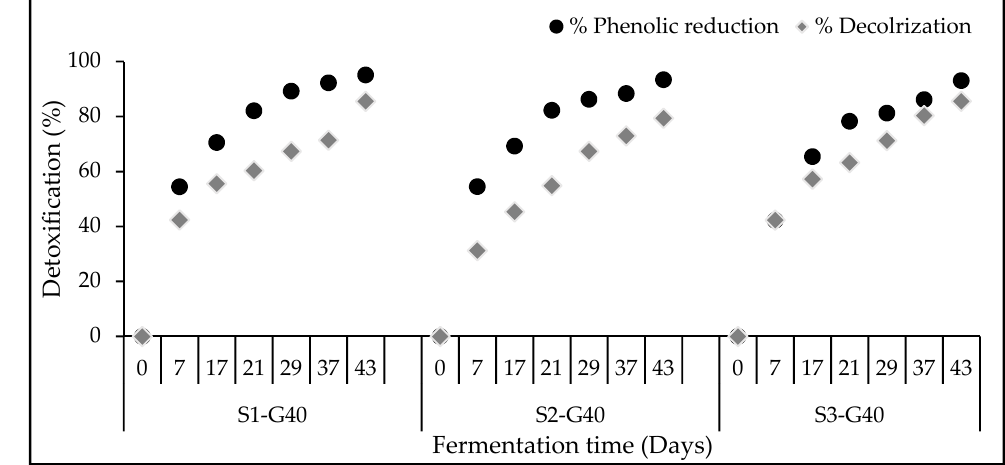
Figure 3. Kinetics of % phenol reduction and % decolorization of the medium during cultivation of P. pulmonarius in liquid cultures with OMWs containing 1, 2 and 3 g/L phenolic compounds and initial concertation glucose ( a ) 40 g/L (S1-G40, S2-G40, S3-G40) and ( b ) 60 g/L (S1-G60, S2-G60, S3- G60, see Table 2). Each point is the mean value of at least three independent measurements, SD < 5%. can produce ligninolytic enzymes that degrade the phenolic compounds. In particular, the ability of detoxification and decolorization of P. citrinopileatus LGAM 28684, in batch cul- tures with a concentration of OMW (25%, v/v ) was studied by Zerva et al. [53] and a re- duction of phenolic compounds by 86.4% and decolorization by 79.1%, after fermentation of 22 days, was achieved. Yesalida et al. [41] recorded a 60% decrease in phenolics by P. sajor-caju and 35–45% by P. ostreatus . Moreover, phenolic compound reduction achieved by Pleurotus and Ganoderma spp. was significantly high (74–81 and 64–67%, respectively) in crops with an OMW of 25% v/v after 20 days of fermentation, while decolorization of 60–65% and 40–46%, respectively was observed after 30 days of fermentation [42]. Finally, an exceptionally high rate of phenolic reduction (94.5%) and decolorization (76.5%) was recorded recently in static culture trials performed by a newly isolated G. resinaceum mushroom, cultivated on various OMW-based media enriched with glucose [9]. There- fore, great detoxification of OMW was achieved by P. pulmonarius in the present study. 3.3. IPS Synthesis and Composition The production of IPS at 5 sampling points was also recorded and the maximum val- ues are presented in Table 3. In general, the addition of OMW had a positive effect on